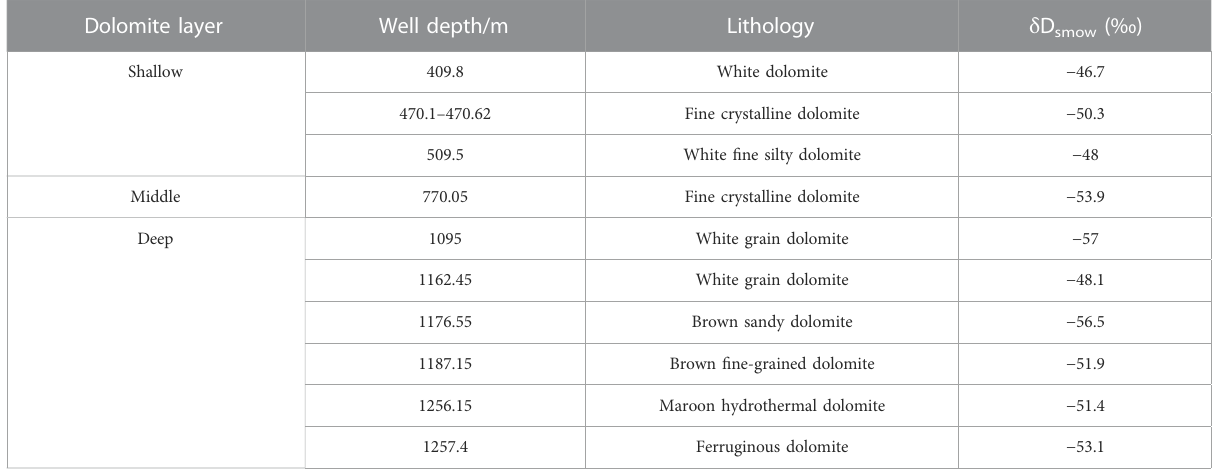
TABLE 3 Test results of hydrogen isotopes of dolomites in Well Xike